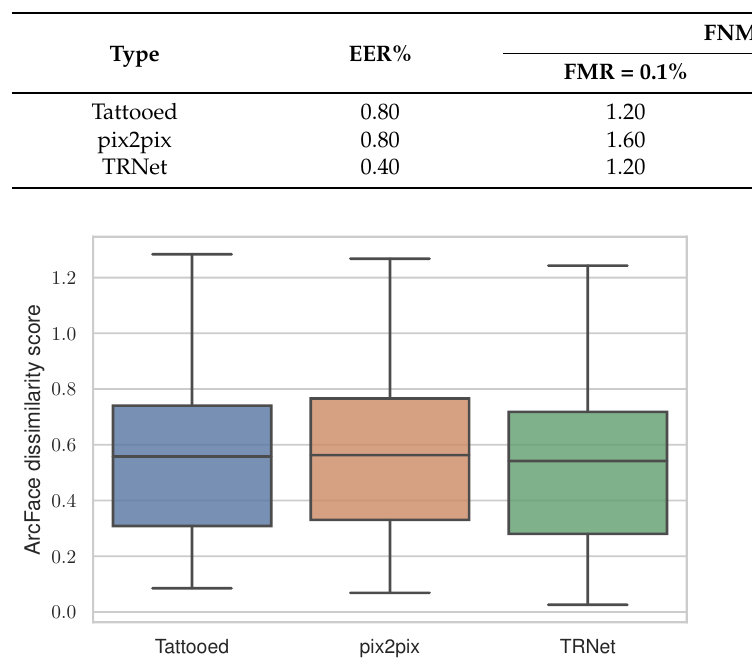
Table 3. Biometric performance results for ArcFace.